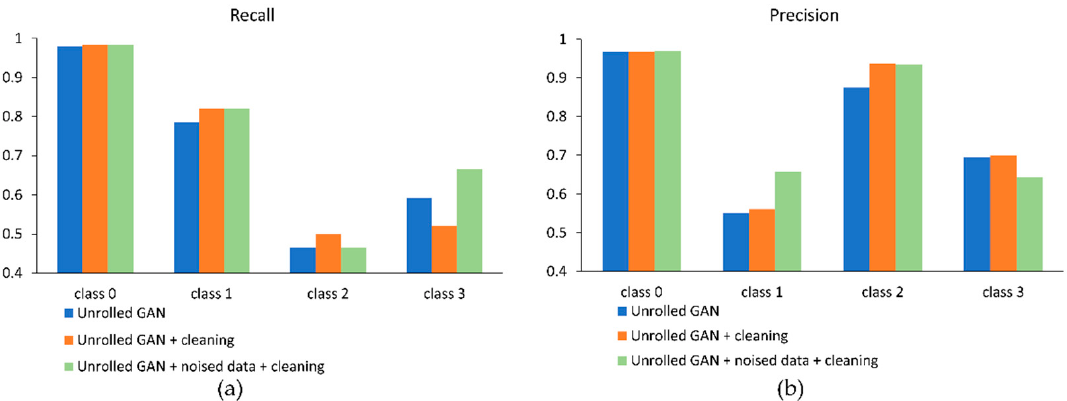
Figure 19. Recall ( a ) and precision ( b ) of the base classifier before and after data cleaning and noised data addition for Fold 2.